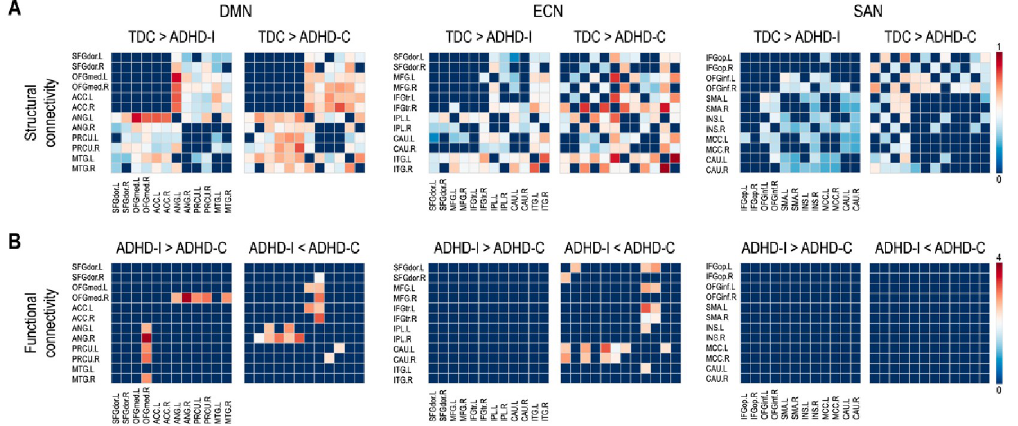
Fig 2. (A) Statistical group differences in structural connectivity between regions of the subnetworks (B) Because functional connectivity measures did not distinguish either ADHD subtype from TDC, only the difference in functional connectivity between the ADHD-I and ADHD-C subtypes are displayed (FDR <